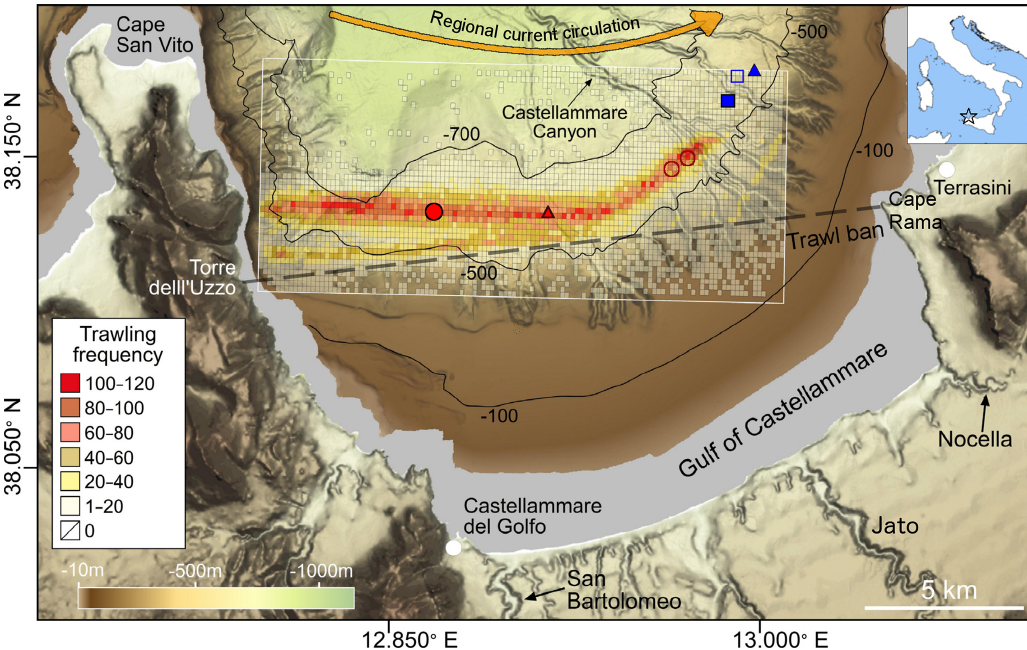
Figure 1. Bathymetric map of the Gulf of Castellammare. Location of the sediment cores sampled at the trawled (red circles) and untrawled (blue squares) sites. Unfilled sampling points indicate unsuccessful sediment core deployments. Seafloor images obtained from ROV dives are shown with triangles (see Fig. S1). The distribution of trawling grounds as trawling frequency (number of total hauls per grid area) in 2016 (1 January to 10 August) was calculated for a 200m × 200m grid. The limit of the trawl banned area between Torre dell’Uzzo and Cape Rama is indicated by a dashed line. The main trawling harbors (Castellammare del Golfo and Terrasini) and the most relevant ephemeral rivers (San Bartolomeo, Nocella, and Jato) are also annotated. The yellow arrow illustrates the direction of the regional surface